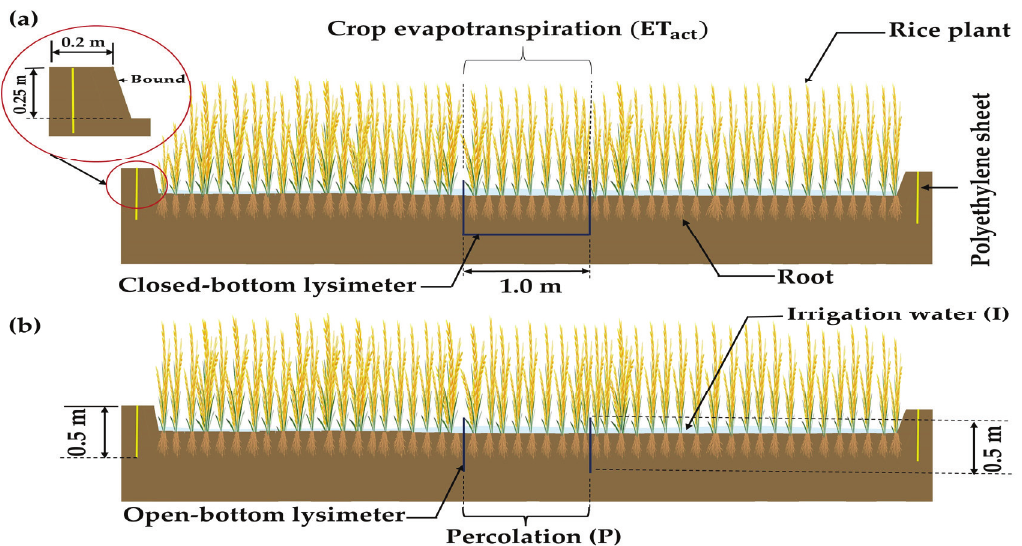
Figure 5. Experimental plot set up. ( a ) Crop evapotranspiration ( b ) Crop evapotranspiration plus Percolation